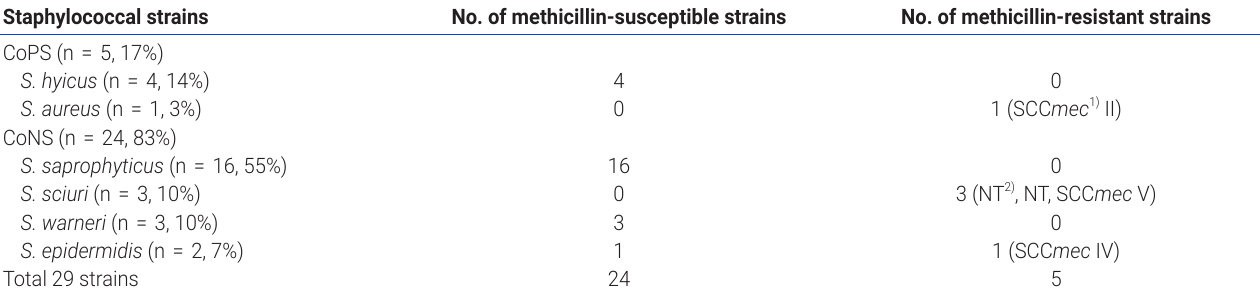
Table 1. Profiles of Staphylococcus spp. isolated from 260 pork meat samples Staphylococcal strains No. of methicillin-susceptible